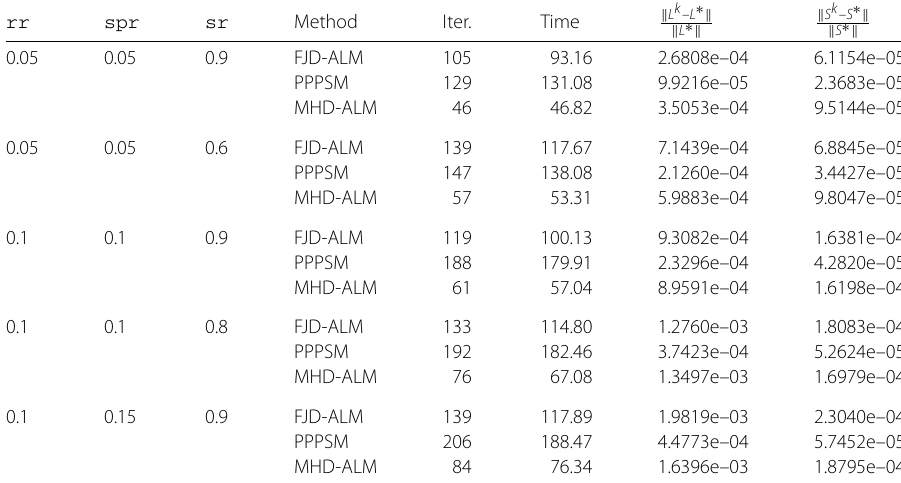
Table 2 Numerical comparisons between different algorithms for p = q = 1000 rr spr sr Method Iter.